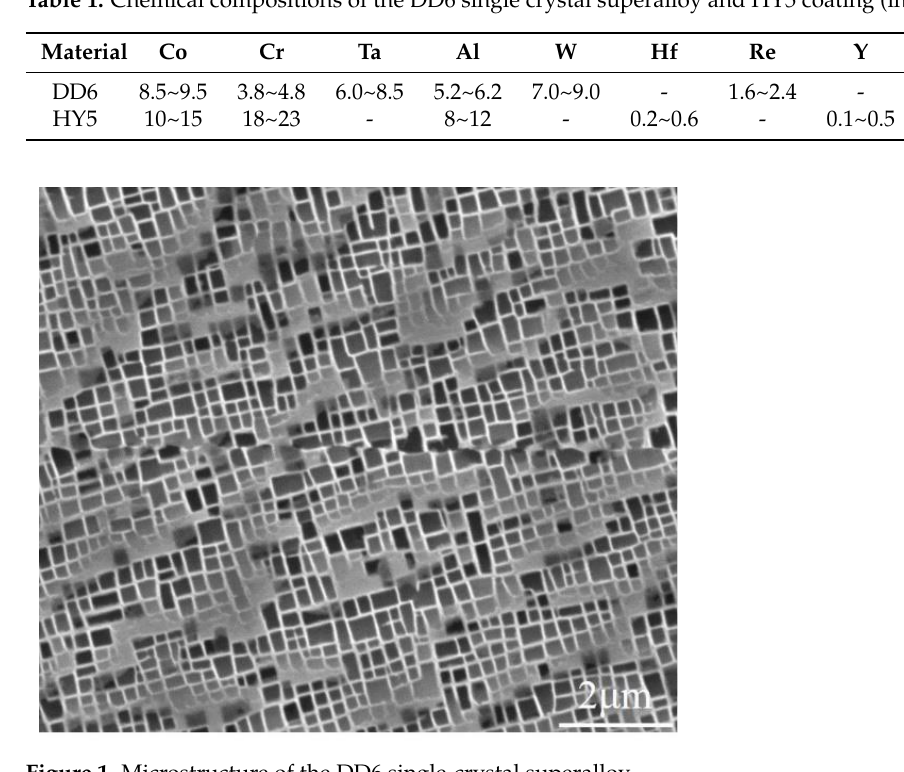
Figure 1. Microstructure of the DD6 single-crystal superalloy. Rectangular specimens with dimensions 30 mm × 10 mm × 1.5 mm were machined from the DD6 single crystal alloy rod. The surfaces were polished with SiC